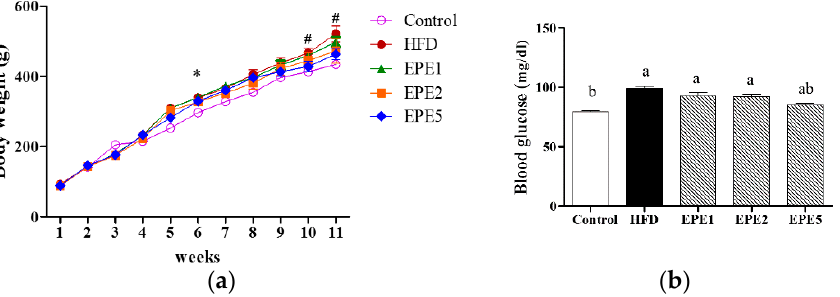
Figure 1. Effects of Echinacea purpurea ethanol extract on ( a ) body weight change and ( b ) blood glucose level in high-fat diet (HFD)-induced obese rats. Data are shown as the mean ± standard error of the mean (S.E.M.) ( n = 5). The values with different superscript letters ( a , b ) are significantly different ( p < 0.05), as determined via one-way analysis of variance (ANOVA), and were analyzed by Duncan’s multiple range test. * p < 0.05 control versus HFD, EPE1, EPE2, and EPE5 and # p < 0.05 HFD versus EPE5.